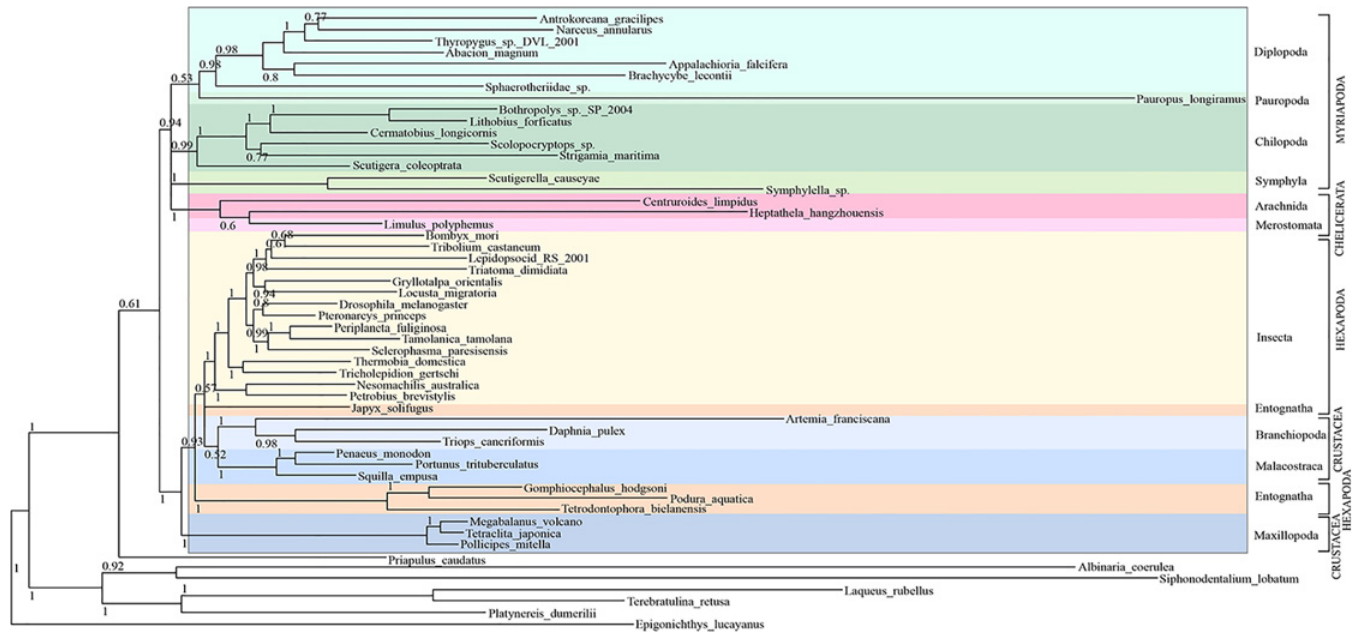
Fig 4. Bayesian phylogenetic analysis of mitochondrial protein-coding genes from Arthropoda species including S . maritima . Support values at nodes are Bayesian Posterior Probability (BPP). Myriapoda and Chelicerata, ‘ Myriochelata ’ (BPP = 0.94) resolved as the sister group to Pancrustacea (Crustacea and Hexapoda, BPP = 1.0). A monophyletic Chilopoda is resolved with BPP = 0.99, within which Scutigeromorpha ( Scutigera coleoptrata ) are resolved as the sister group to the three remaining chilopod orders represented in our phylogeny (Lithobiomorpha, ( Bothropolys sp ., Lithobius forficatus and Cermatobius longicornis ); Scolopendromorpha ( Scolopocryptos sp .) and Geophilomorpha ( Strigamia maritima )) with BPP =